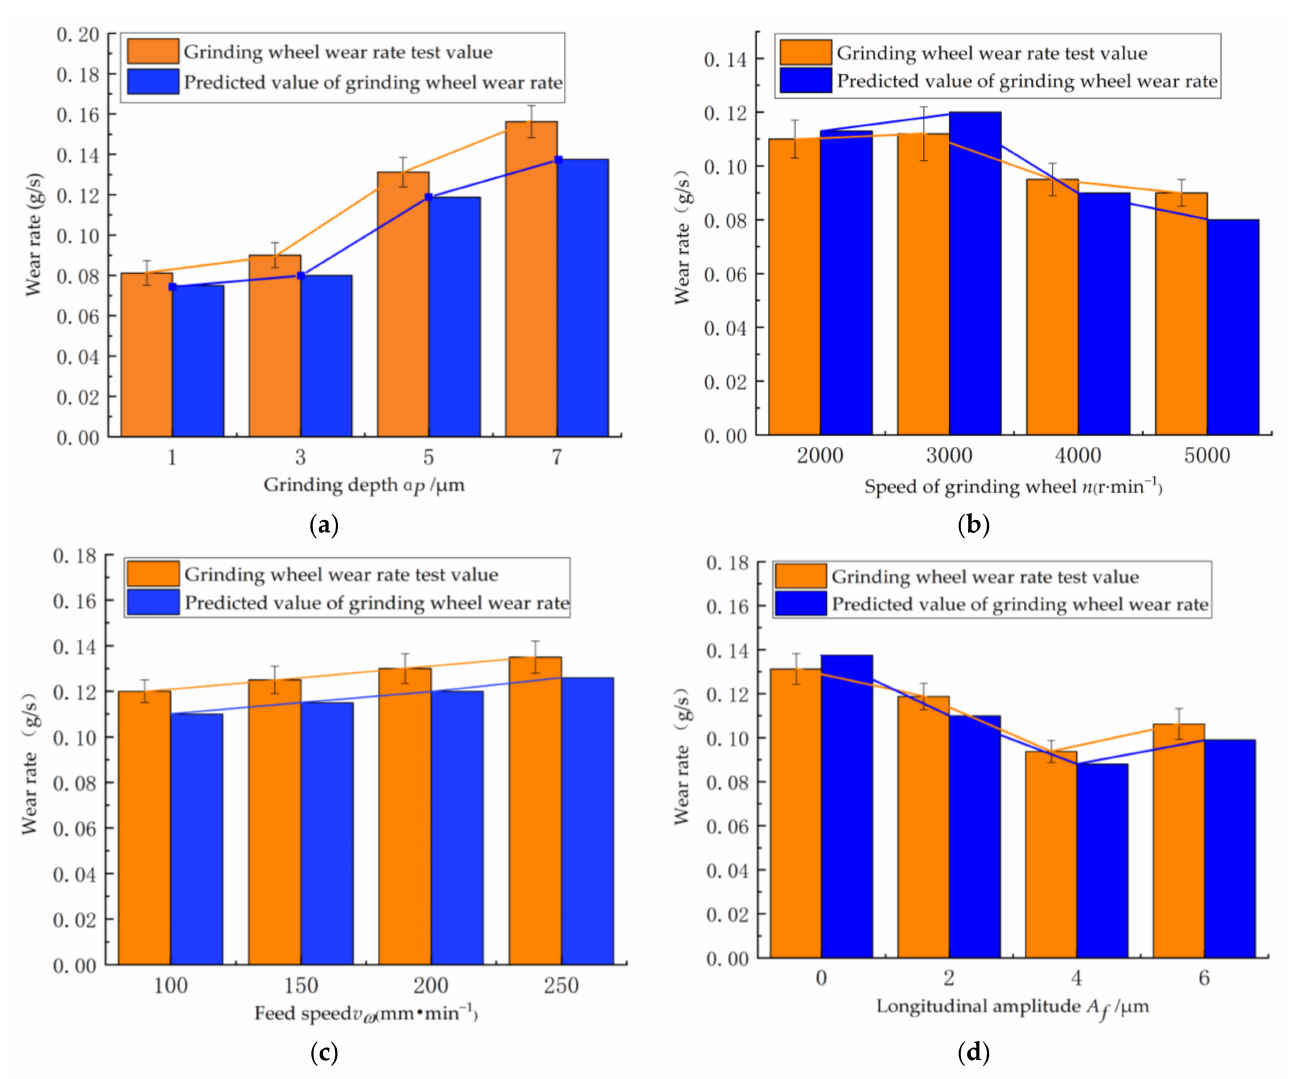
Figure 9. Influence of process parameters on grinding wheel wear rate in LTUAG. ( a ) Depth of grinding. ( b ) Speed of the grinding wheel. ( c ) Feed rate. ( d ) Lengthening